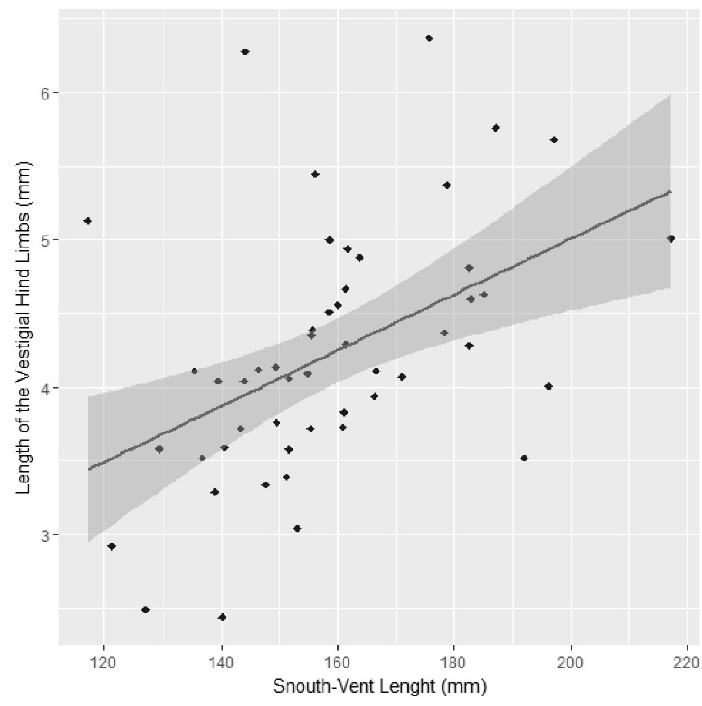
Figure 4. Pearson’s Correlation between snout- vent length (SVL - x) and length of the vestigial hind limbs (LVL - y) of Ophiodes striatus (n = 50). Correlation (x, y) = 0.4587